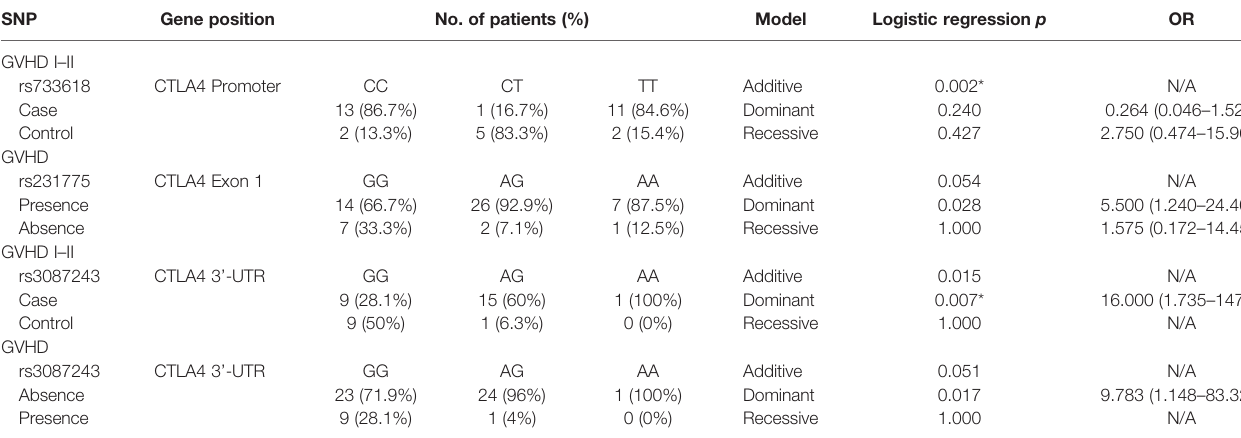
TABLE 3 | The SNPs in the CTLA4 gene associated with the outcomes of post-CBT. SNP Gene position No. of patients (%)